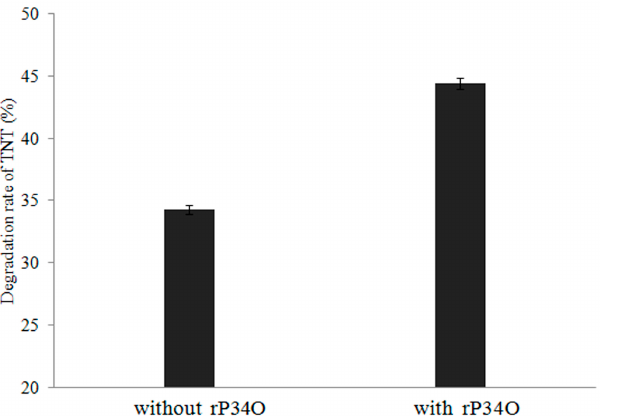
Figure 5. Degradation rates of TNT by Buttiauxella sp. S19-1 with or without rP34O. Data are pre- sented as mean of N = 4, x ± SD. Statistical significance is denoted as p < 0.05 using SPSS.